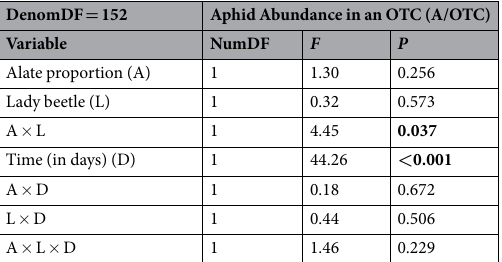
Table 2. Statistical results in the colonization experiment: effects of alate proportion treatment, lady beetle treatment, and time on aphid abundance in an OTC, which included one central and four neighbor plants. The statistical analysis applied linear model using generalized least squares (GLS) with AR1 correlation structure to account for repeated measures of each aphid population. Time effect was treated as a continuous (numeric)